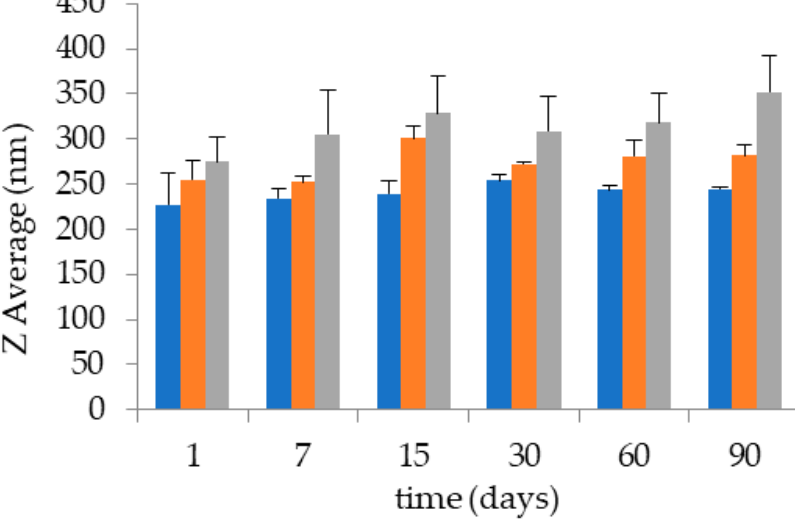
Figure 1. Effect of PC concentration on the stability of ETHO 0.6 (orange), ETHO 0.9 (blue), and ETHO 1.5 (grey). Diameters were measured by PCS and expressed as Z average.